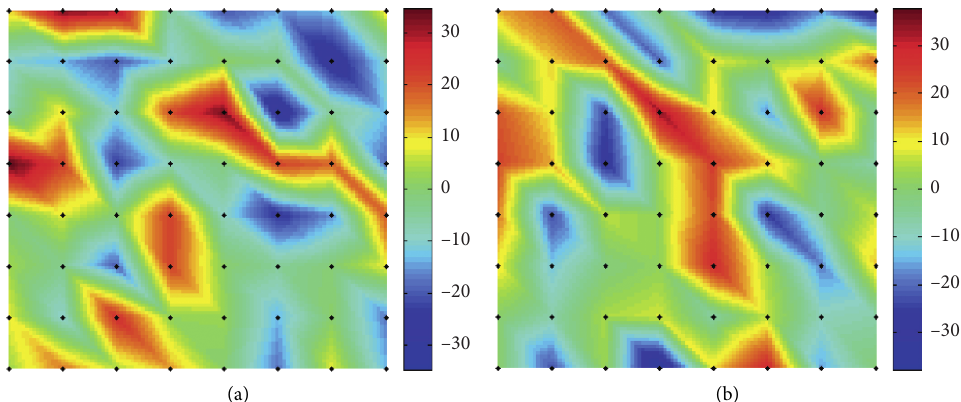
Figure 3: Relative amplitude contribution of (a) trial 9 and (b) trial 10. Black dots denote 64 channels, and each color bar represents the range of signal